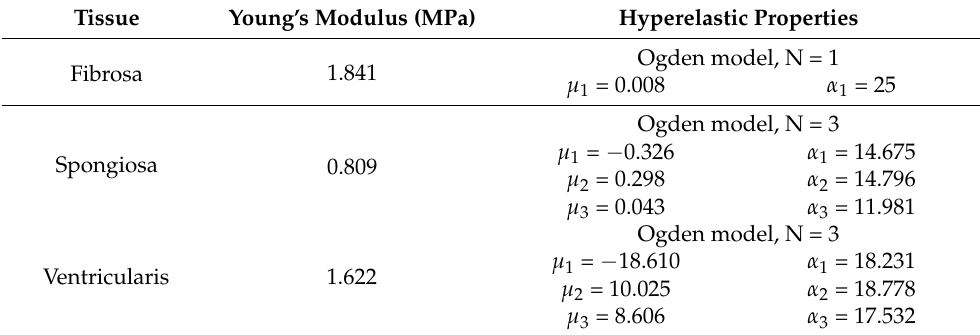
Table 1. Hyperelastic and elastic parameters for the tissue of animal origin materials